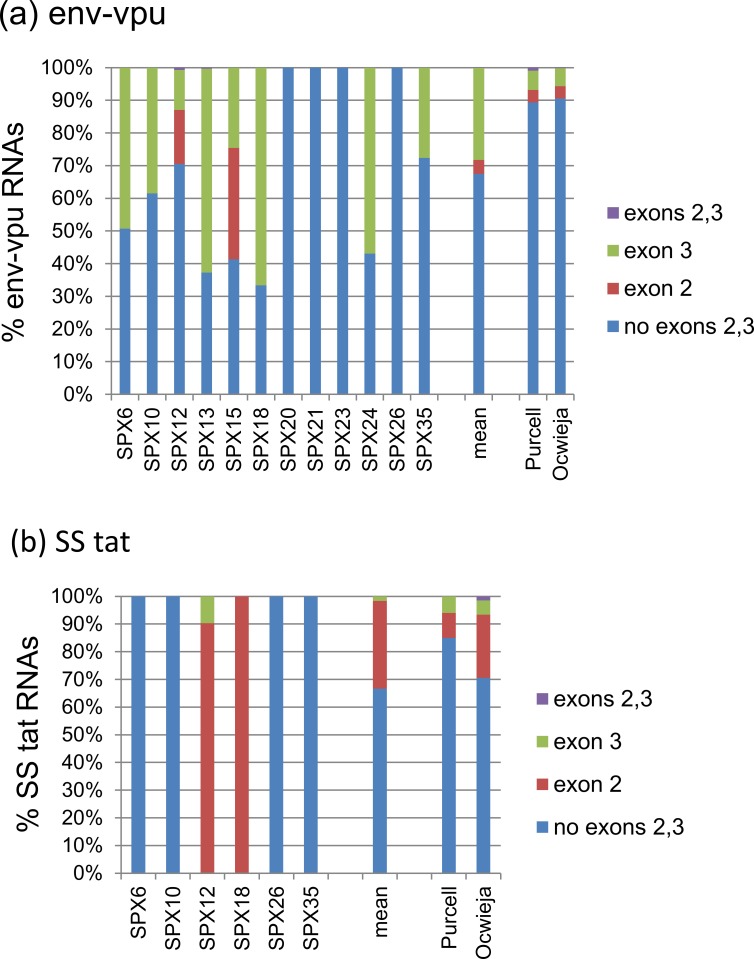
Frequency of incorporation of noncoding exons in SS RNAs among (a) env-vpu and (b) tat RNAs. The vertical axis represents proportions relative to all transcripts of each class. Mean proportions of all samples are shown on the right of the columns for individual samples. For comparison, proportions reported in in vitro studies by Purcell and Martin [6], and Ocwieja et al. [9] are shown.